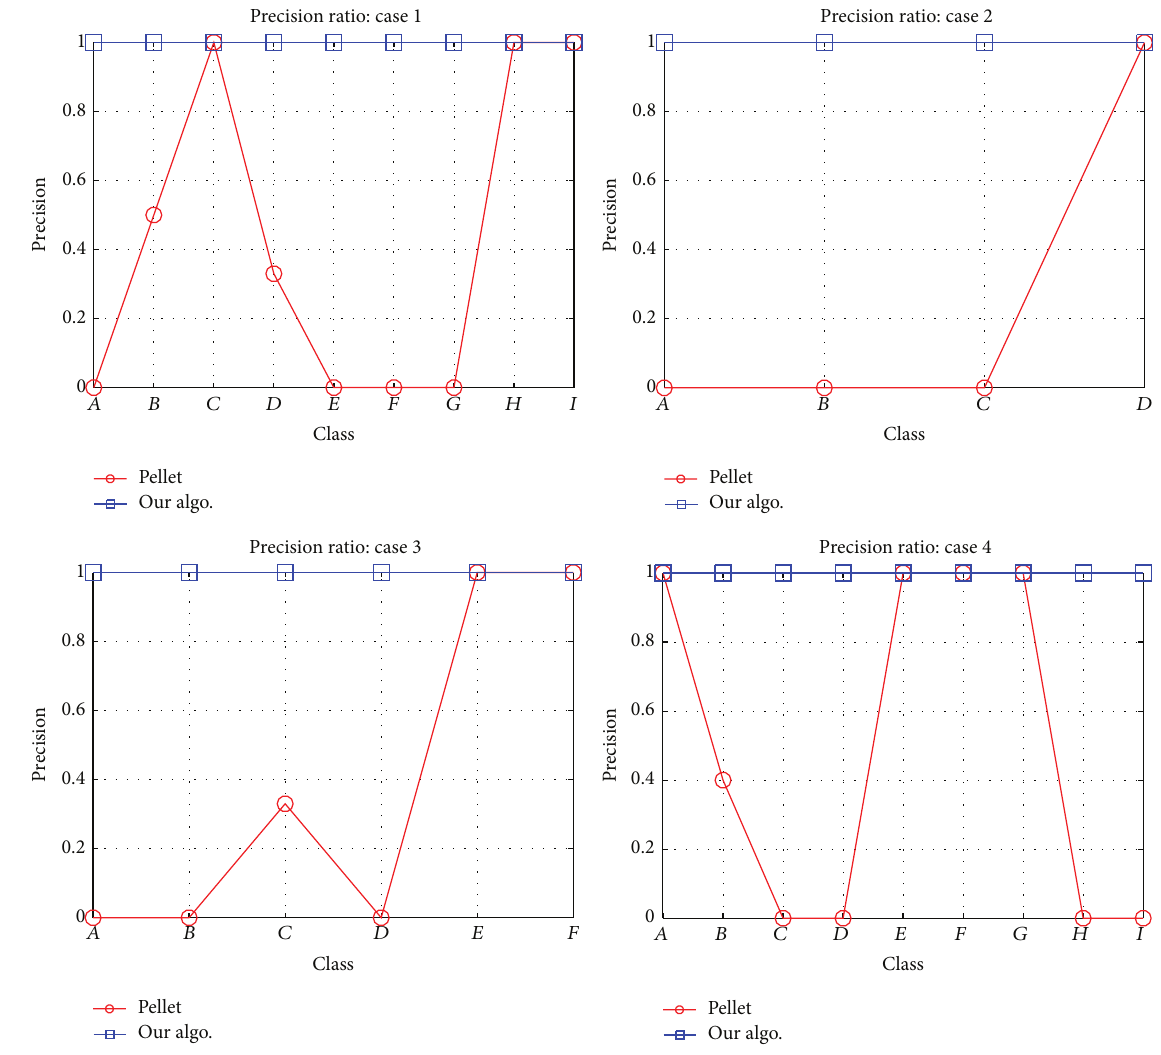
Figure 5: Subclasses calculation precision ratio by Pellet and our algo.: cases 1, 2, 3, and 4.